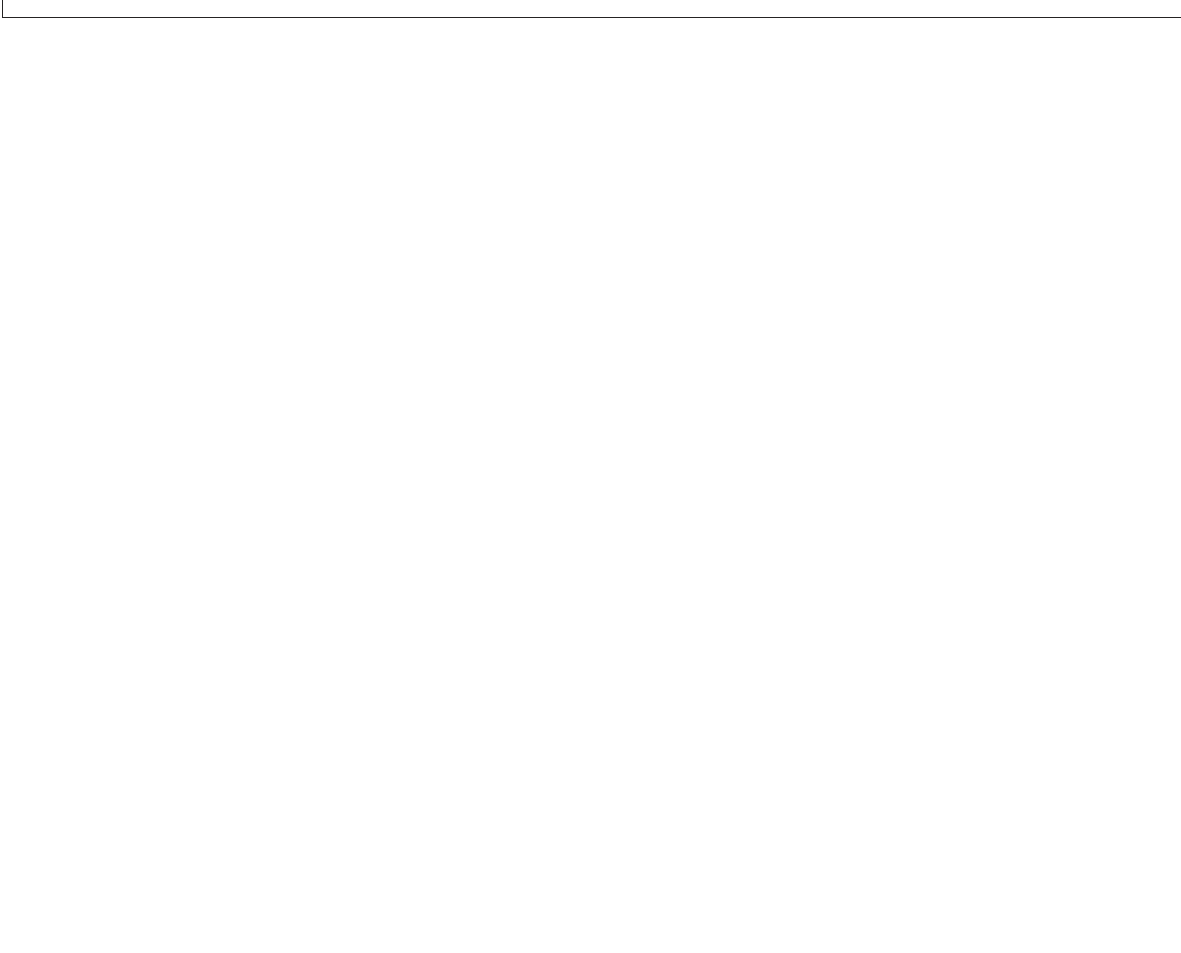
FIGUREA1 Age distribution of the sample ( N =